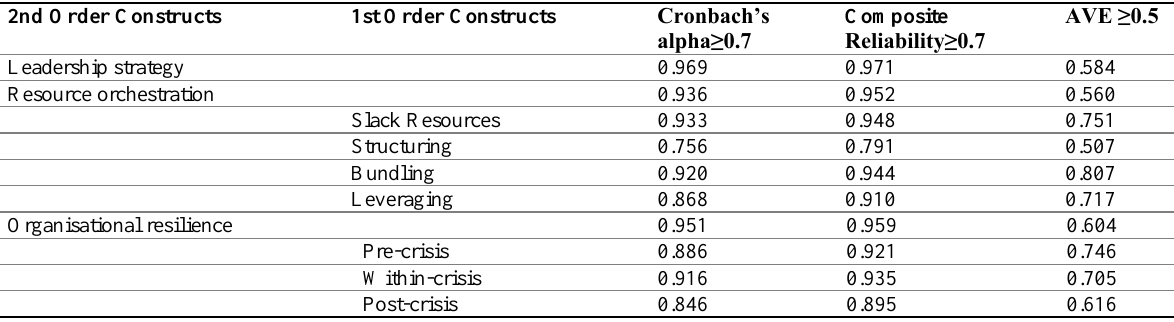
Table 1: Reliability Statistics